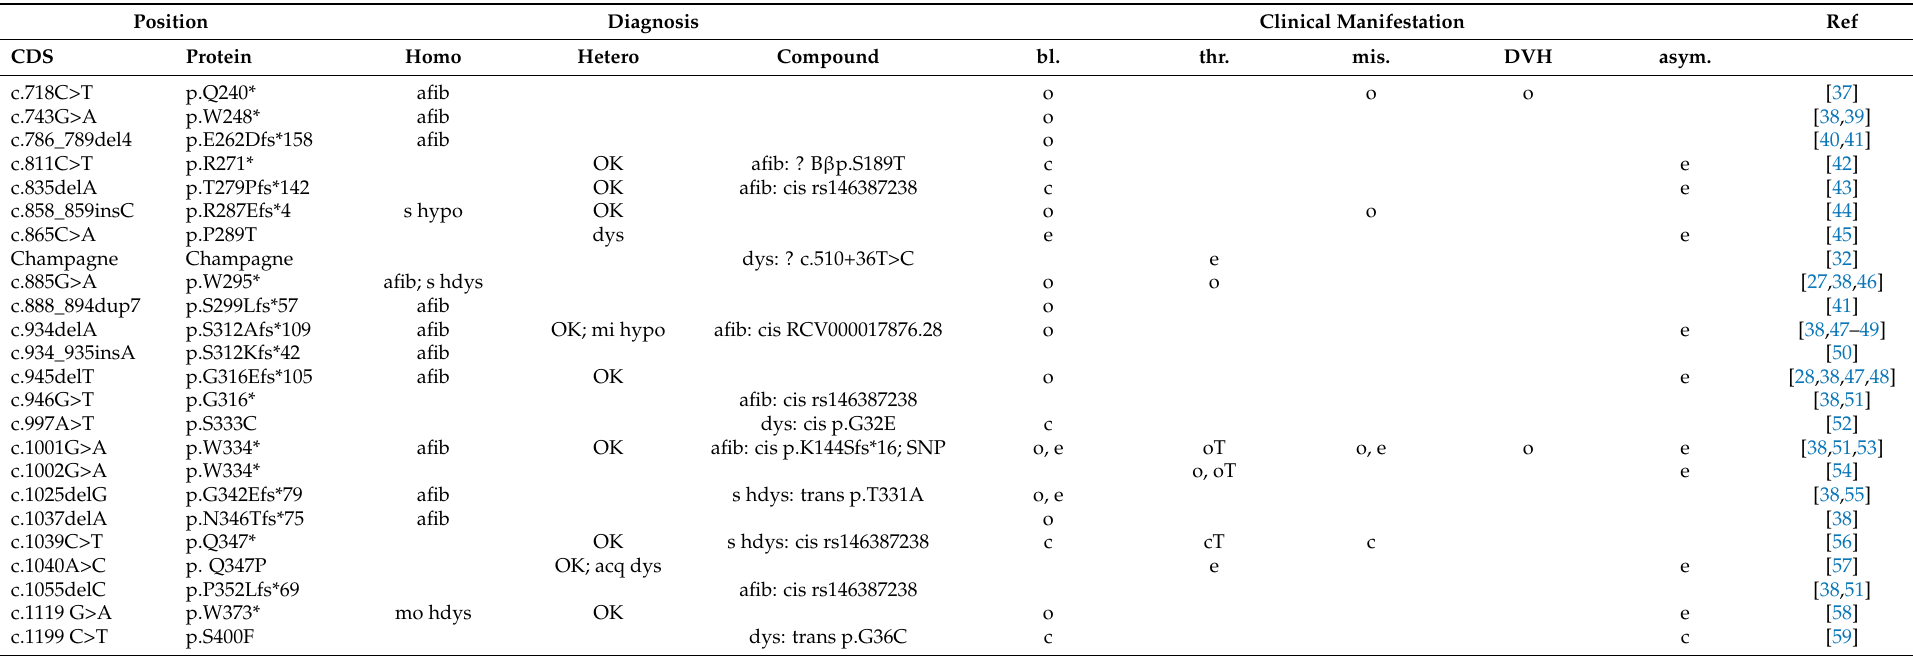
Table 1. (previous page). List of unique mutations in the α C-connector of fibrinogen and their positions in the protein (nascent chain, reference NP_068657.1) and coding (CDS of NM_021871.4) sequences. Champagne = complex fibrinogen Champagne au Mont d’Or. The table further reports CFD in relation to